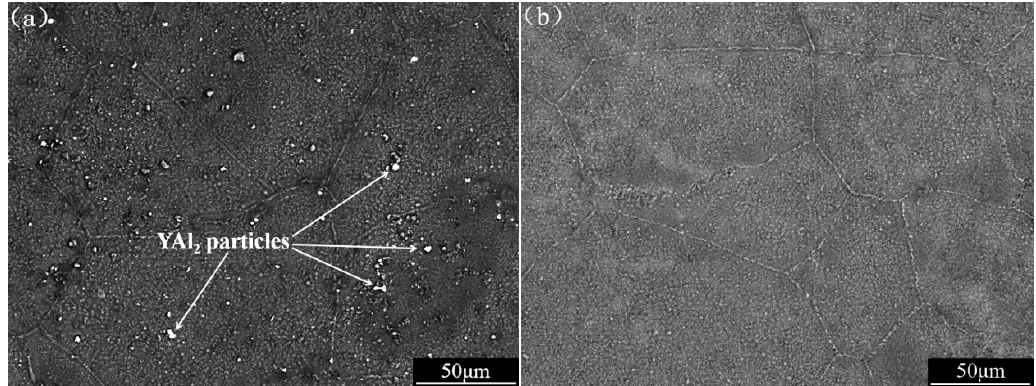
Figure 1. The SEM (backscatter electron) micrograph of ( a ) YAl 2 reinforced LA143 matrix composite and ( b ) LA143